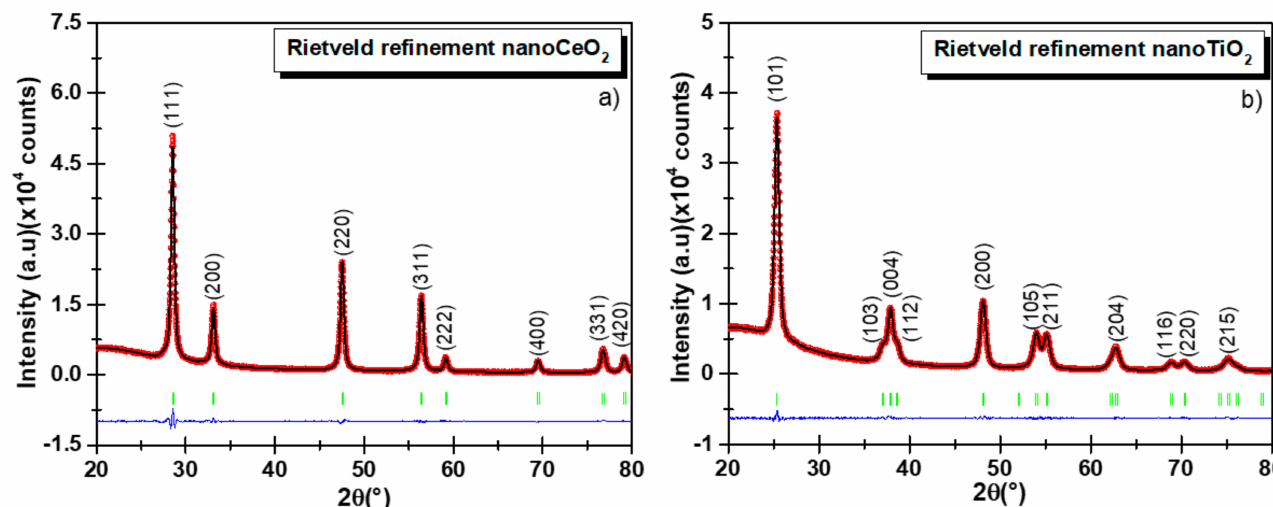
Figure 5. Rietveld refinement of XRD diffractograms using the Thompson–Cox–Hastings (TCH) function for CeO 2 ( a ) and TiO 2 NPs ( b ). The observed experimental diffractograms are given by the red lines (I obs ), the black lines (I cal ) are calculated diffractograms, and the residual lines are shown in blue color. The refinement parameters are reported in Table